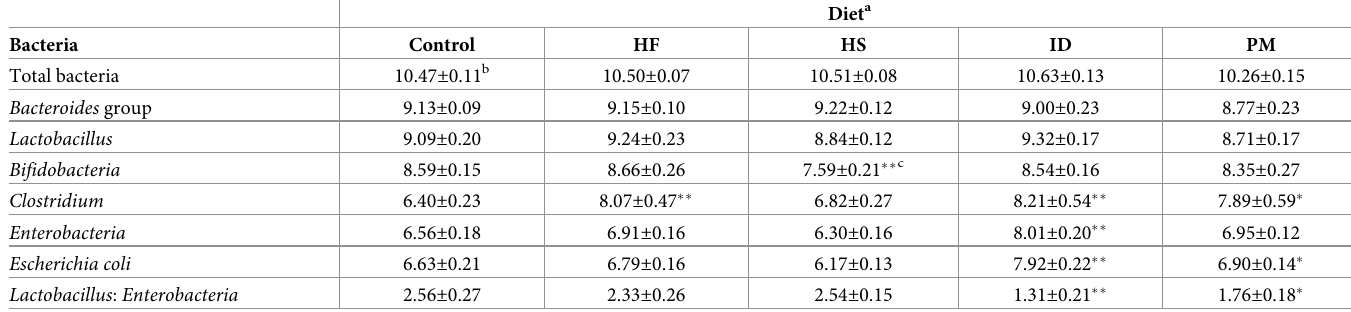
Table 2. The counts (log 10 16S rDNA gene copies g -1 of colonic digesta) of different bacteria groups measured by quantitative real-time